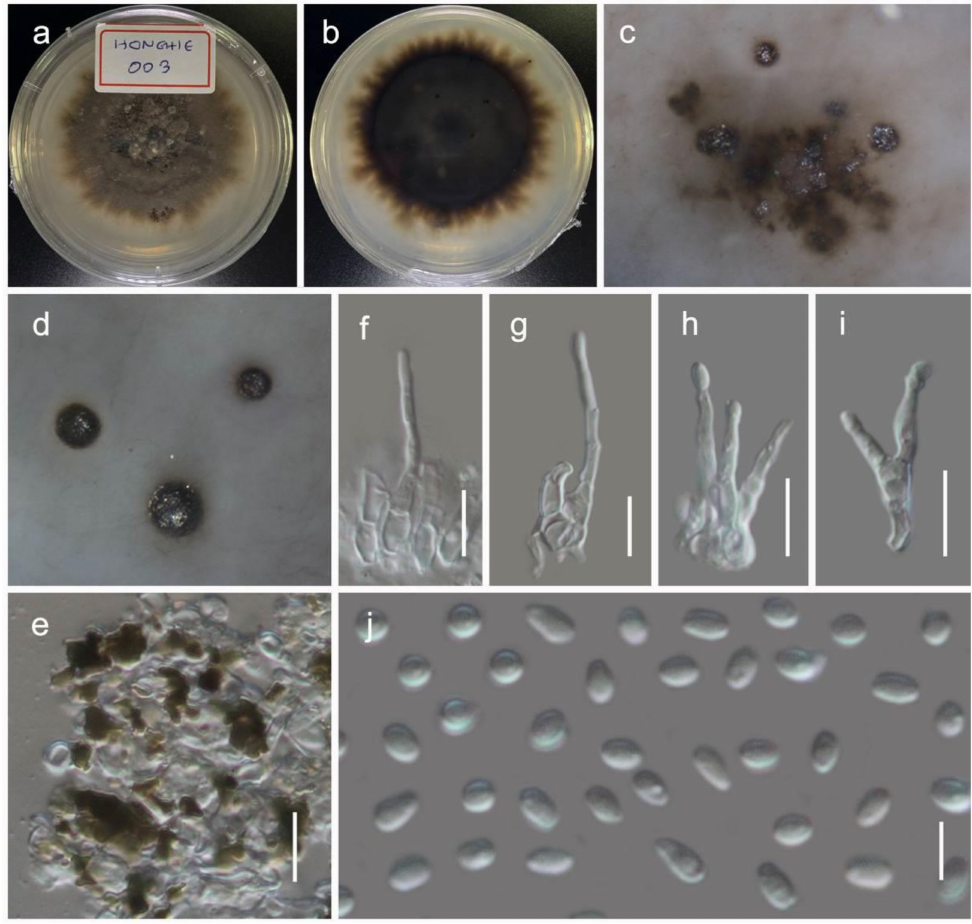
Figure 8. Asexual morph of Lophiomurispora hongheensis (KUMCC 20-0217, ex-type culture). ( a,b ) colony on PDA ( b from the bottom); ( c,d ) immersed pycnidia in PDA (from the bottom); ( e ) pycnidia wall; ( f – i ) conidiophore; ( j ) conidia. Scale bars, ( e – i ) 10 µ m; ( j ) 5 µ